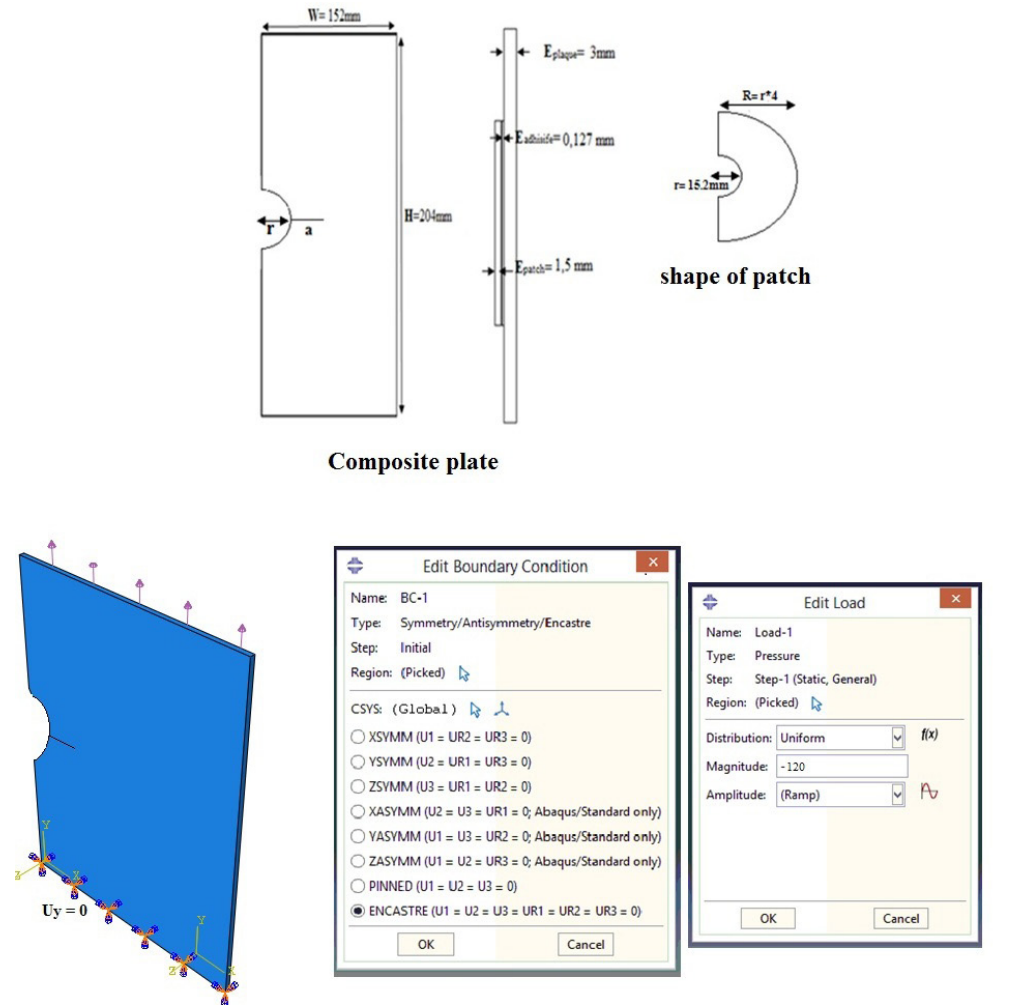
Figure 1. Geometric model.